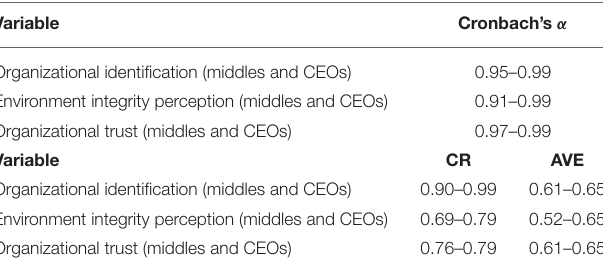
TABLE 4 | Reliability and validity test of